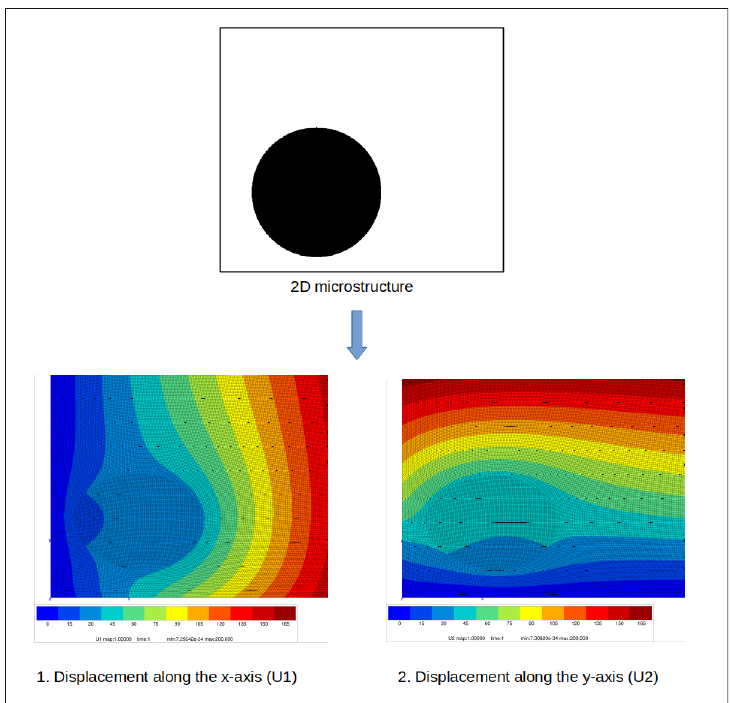
Figure 5. Example of a finite element calculation of the bulk modulus based on a 2D morphological image of a